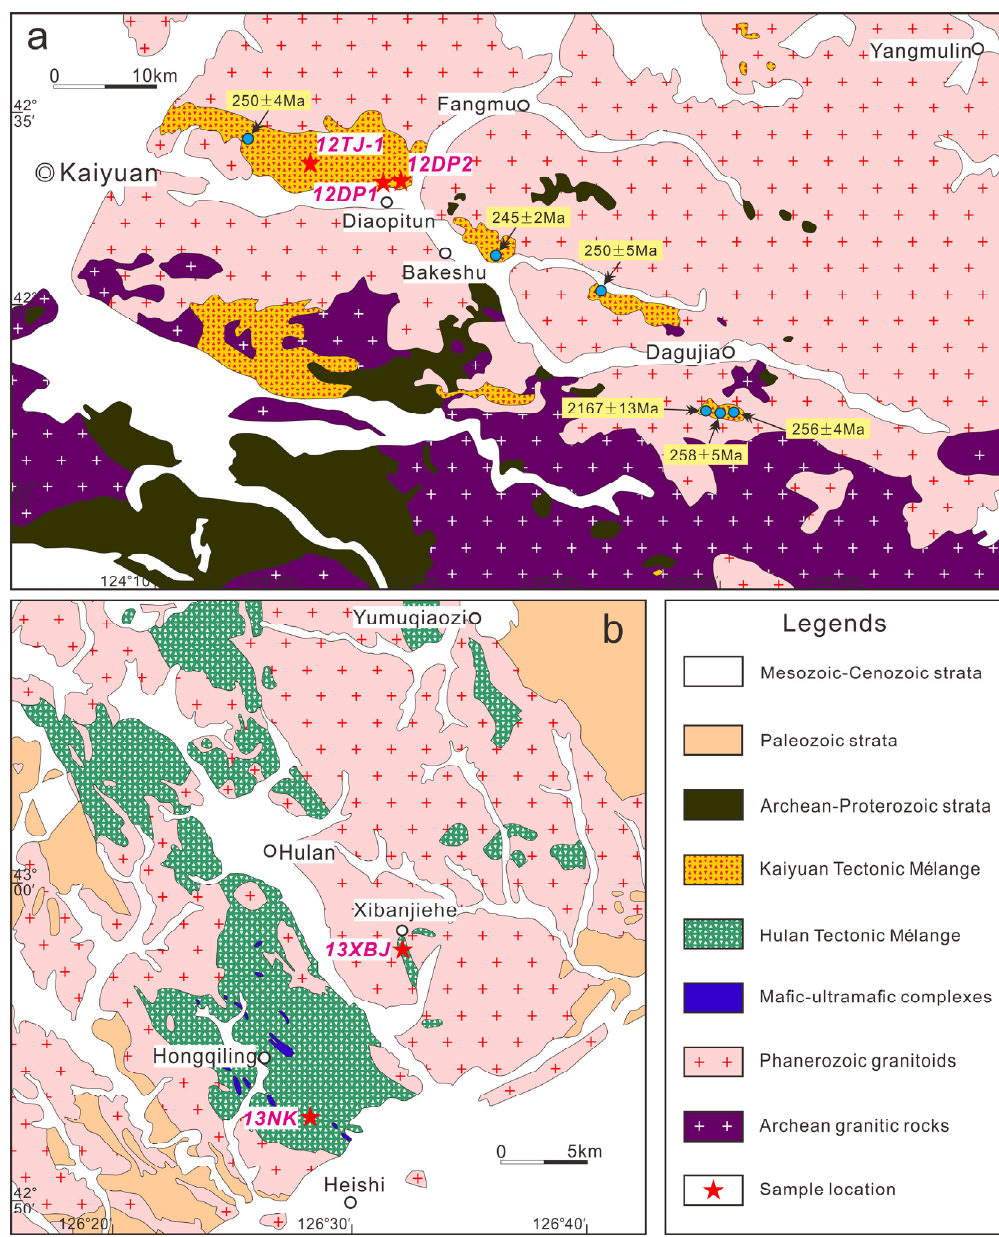
Figure 2. Geological map of ( a ) Kaiyuan and ( b ) Hulan regions showing the distribution of Kaiyuan and Hulan tectonic mélanges (modified from the works in [28, 41 ], respectively). Age data are referred from the works in [38,41,48,79] .